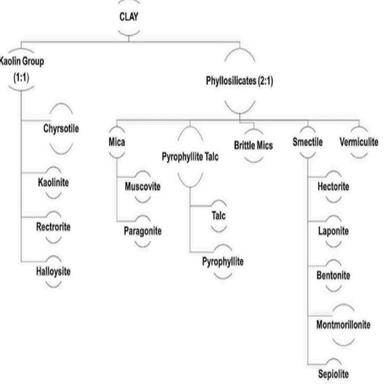
Types of clays.